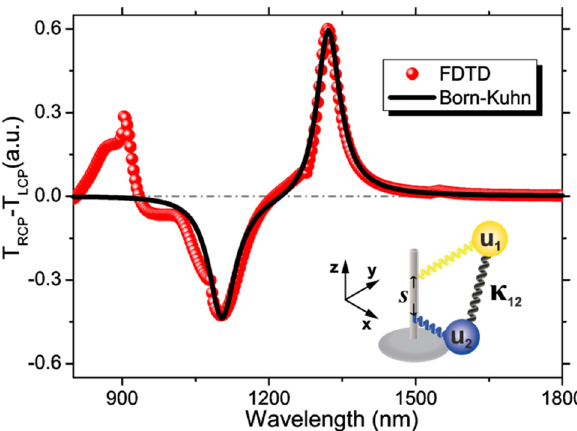
Figure 10: Comparison between the calculated CD in transmission (circular points) and the fitted spectra from the Born – Kuhn model (solid line) for the chiral quadrumer array shown in Figure 8. Inset: the plasmonic Bohn – Kuhn model with only the longitudinal resonances of the upper and bottom layers are considered. The fi tting parameters are ω ω 01 = 242.84 THz, 02 = 258.20 THz, a yellow oscillator (u = A e – i ω t ) is placed at the upper layer 1 1 and a blue oscillator (u = A e – i ω t ) is located at the bottom 2 2 layer. In the modi fi ed Born – Kuhn model, each oscillator represents the collective SLR modes of top (bottom) reso-